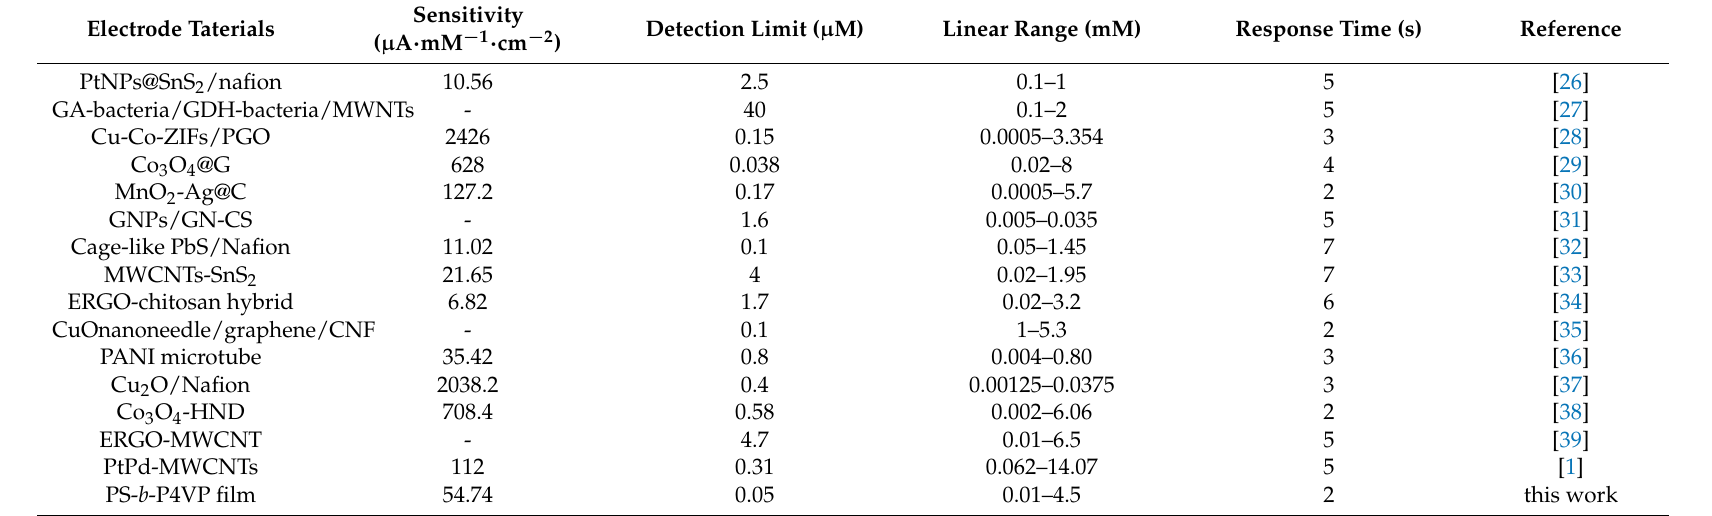
Table 1. Comparison of the amperometric glucose